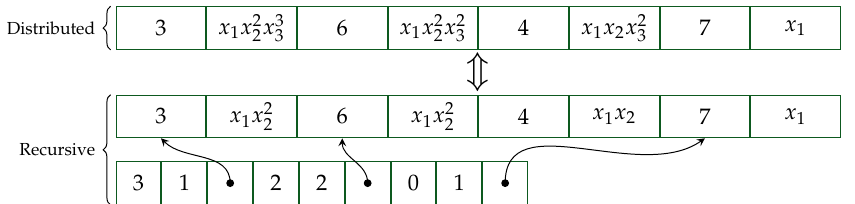
Figure 2. A distributed polynomial representation and its corresponding recursive polynomial representation, showing the additional secondary array. The secondary array alternates between: ( 1 ) degree of the main variable, ( 2 ) size of the coefficient polynomial, and ( 3 ) a pointer to the coefficient polynomial, which is simply an offset into the original distributed